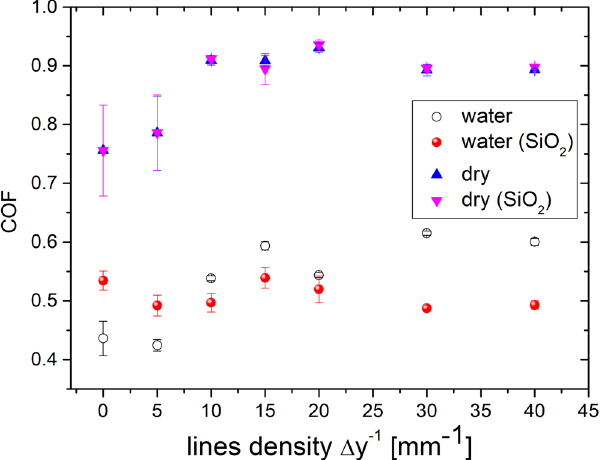
Figure 4. Friction coefficient (COF) in dry and water environments as a function of increasing line density ∆ y − 1 on a laser-textured AISI 316 L without and with 30-nm FAS-SiO